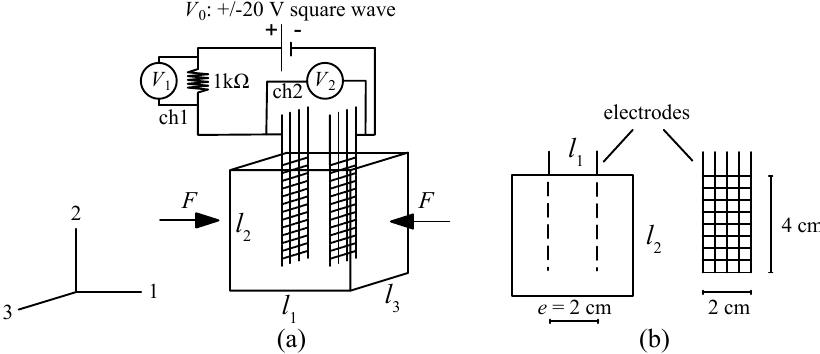
Figure 2. ( a ) Illustration of a cubic sample, loading, and data acquisition; ( b ) steel net electrodes and their placement.